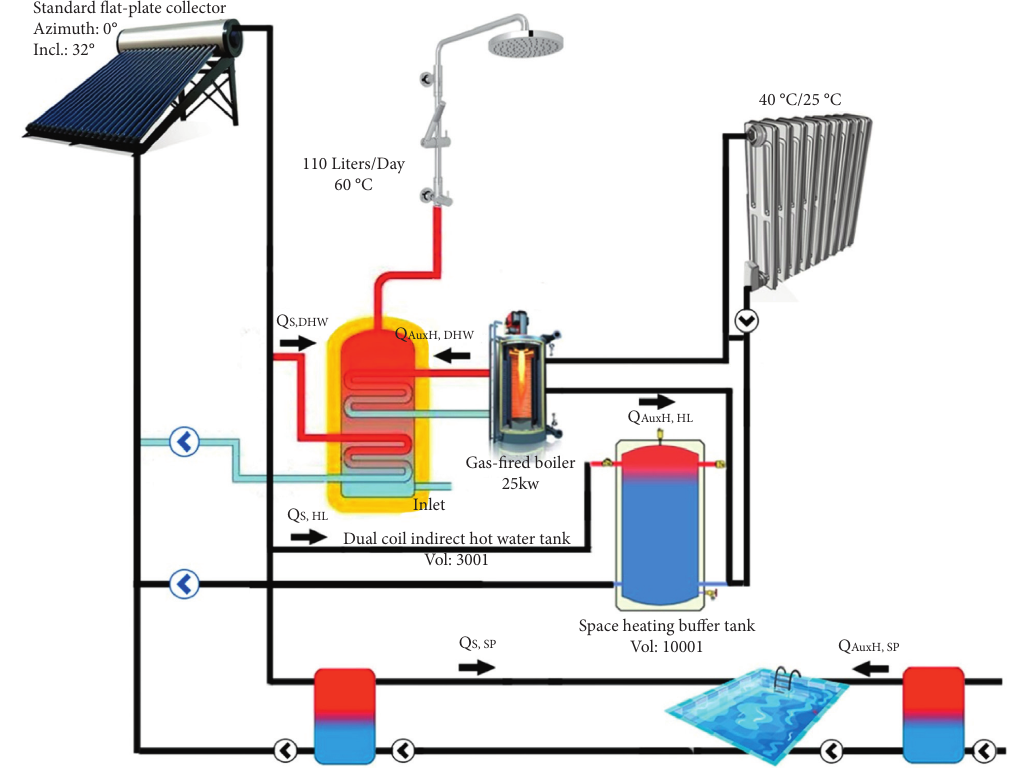
Figure 5: Schematic of the simulated